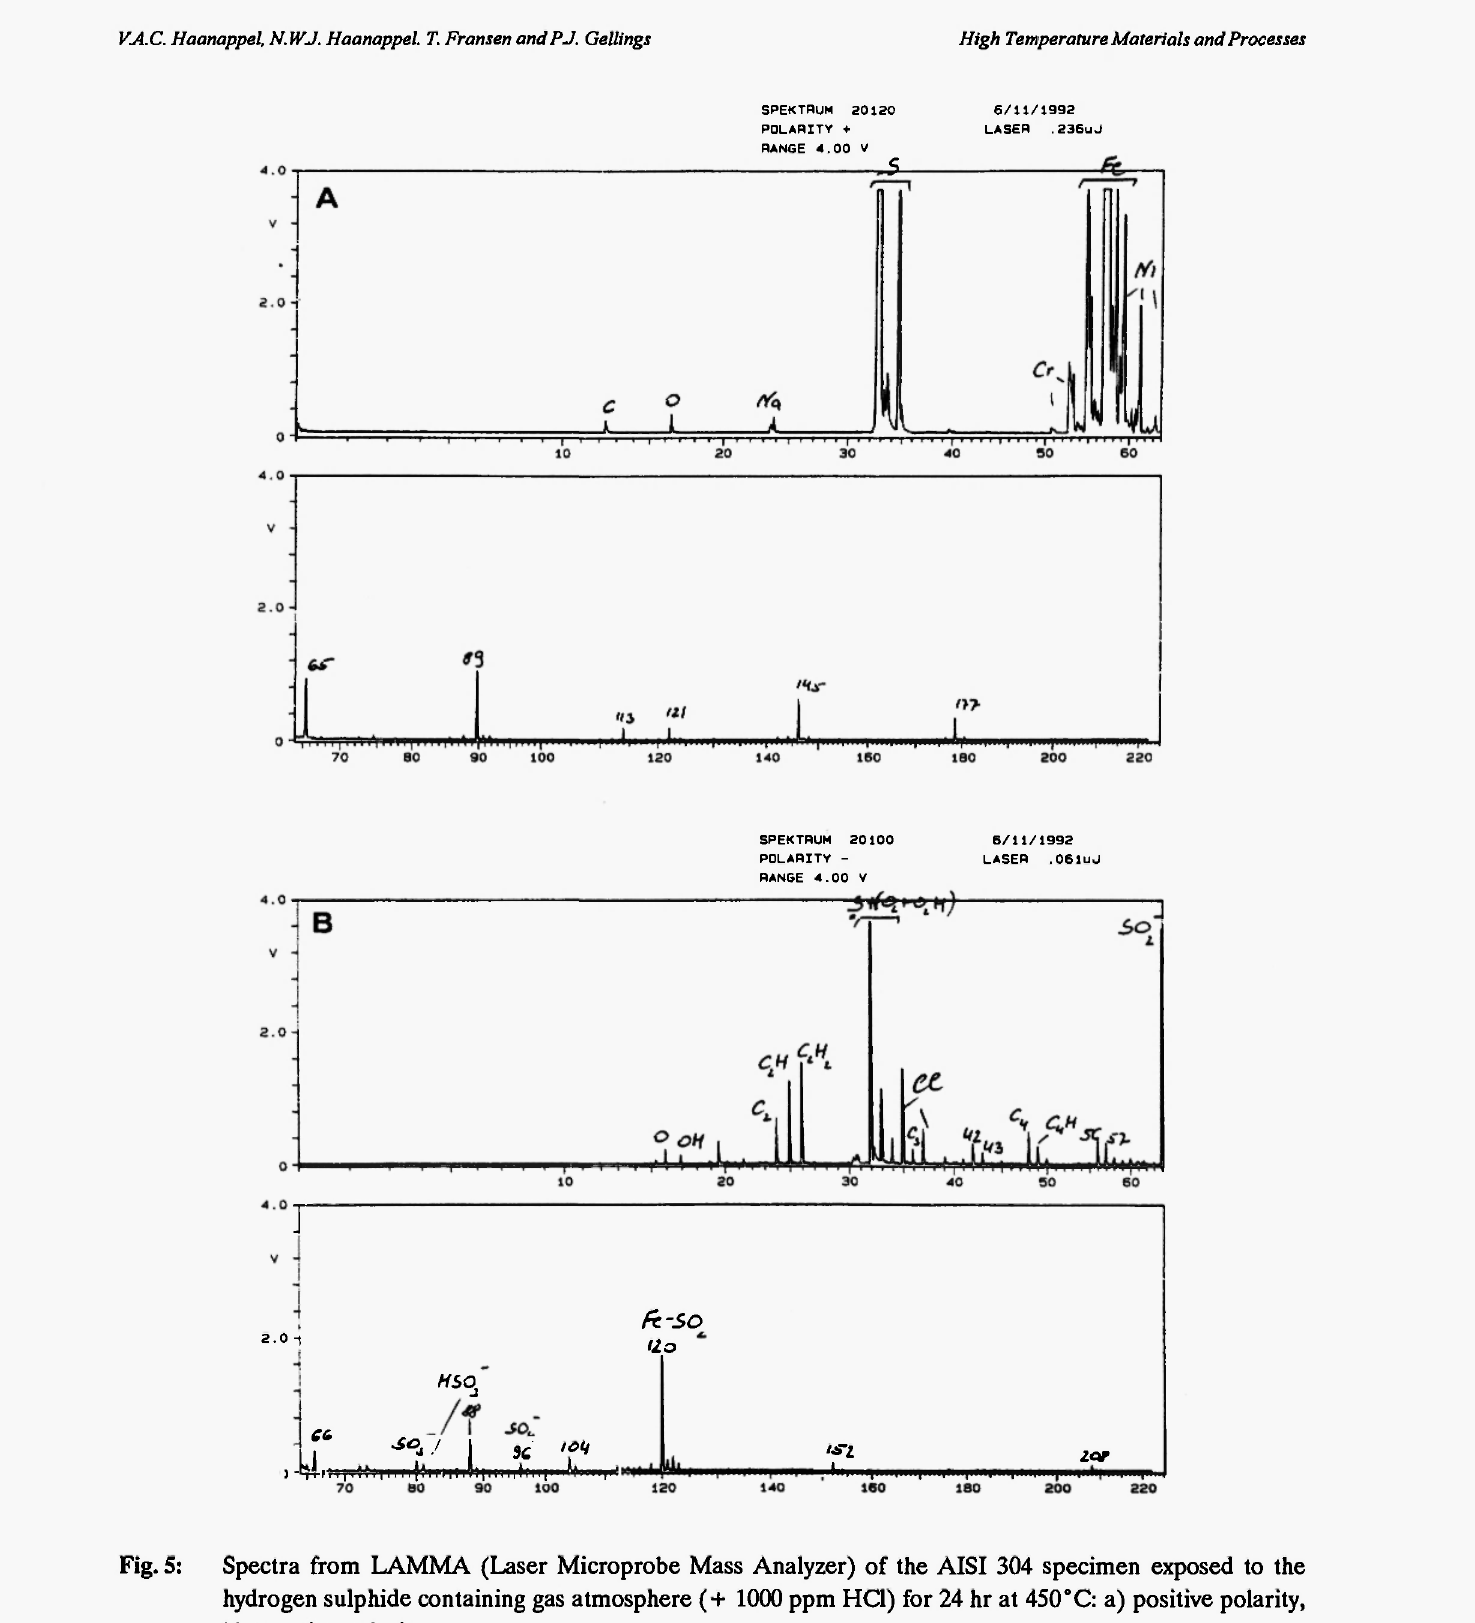
Fig. 5: Spectra from LAMMA (Laser Microprobe Mass Analyzer) of the AISI 304 specimen exposed to the hydrogen sulphide containing gas atmosphere (+ 1000 ppm HCl) for 24 hr at 450 °C: a) positive polarity, b) negative